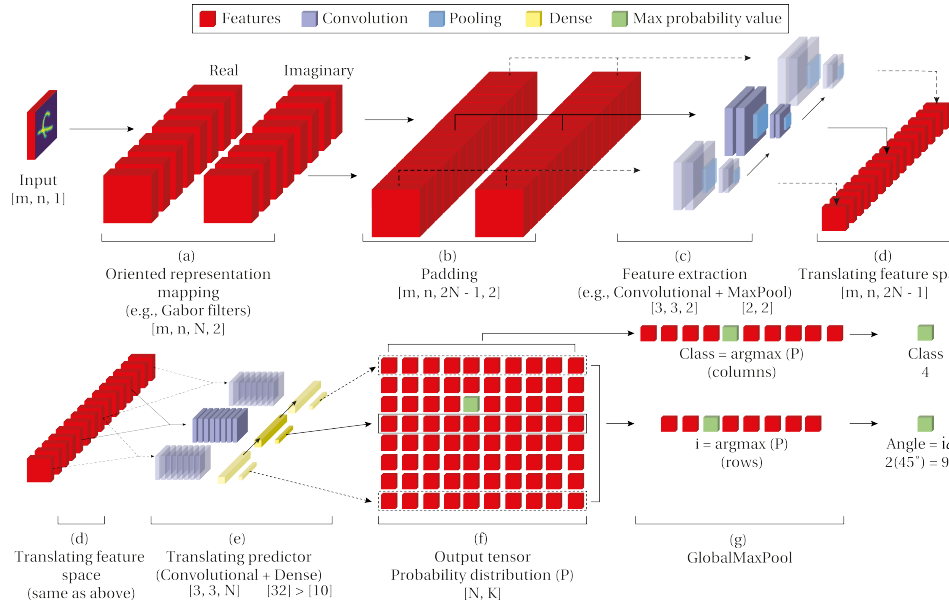
Figure 1. Rotational Invariant CNN architecture. Input is class number 4 rotated 90° clockwise. ( N = 8, K = 10 convolutions in ( c , e ) scan each place with shared